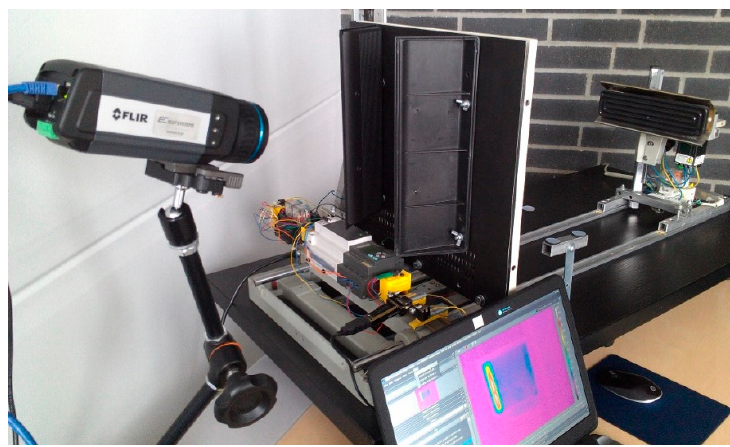
Figure 8. Laboratory test rig for measurements of thermal diffusivity [138].